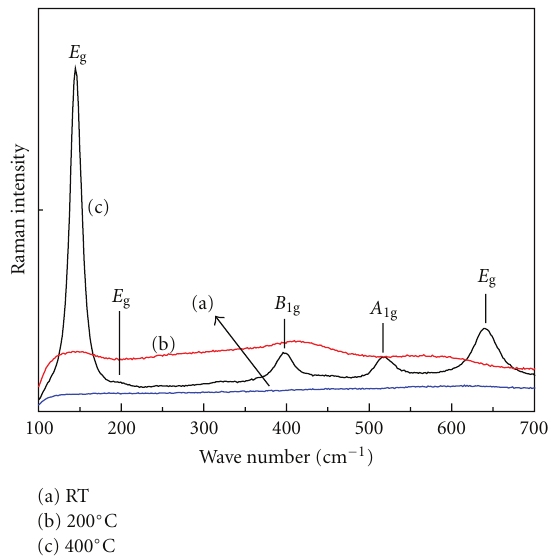
Figure 3: Raman spectra of N-doped TiO 2 films prepared at di ff er- ent temperature, (a) RT, (b) 200 ◦ C, (c) 400 ◦ C.